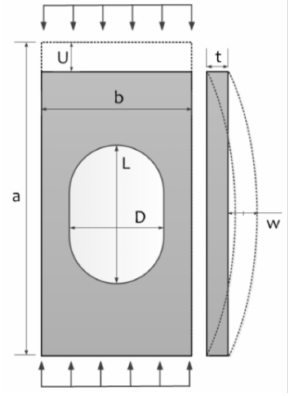
Figure 1. Schematic of dimensions of a perforated